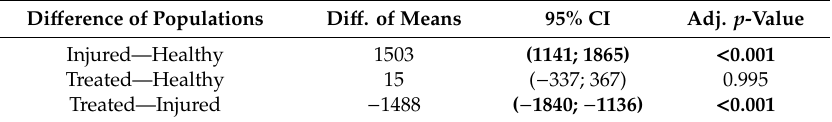
Table 4. Post-hoc pairwise comparisons of the di ff erences between means by the Tukey method. The 95% simultaneous confidence intervals (CI) and adjusted p -values significant at 5% are highlighted in bold.